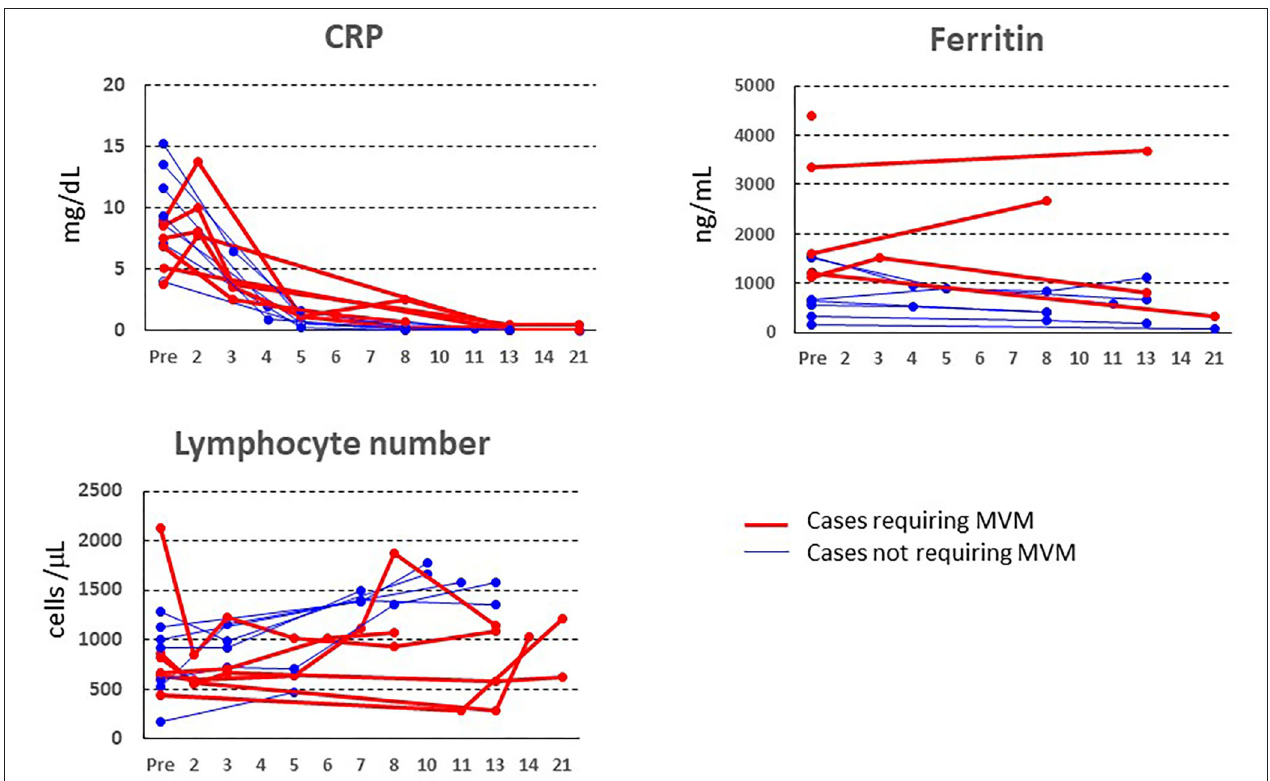
FIGURE 1 | Changes in CRP, ferritin, and peripheral blood lymphocyte number before and after tocilizumab administration. The red line represents the data of patients requiring mechanical ventilation.